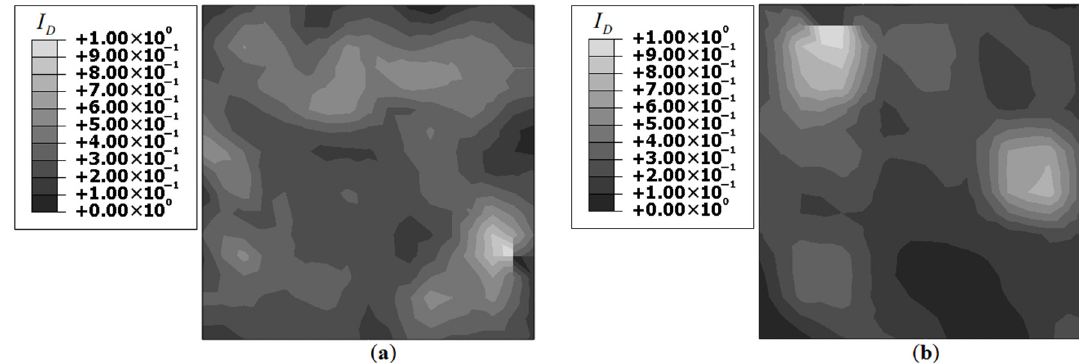
Figure 17. iFEM reconstructed I D distribution for Damage Case-2 (5% noise) using: ( a ) Unitcell-1, and ( b ) Unitcell-2.